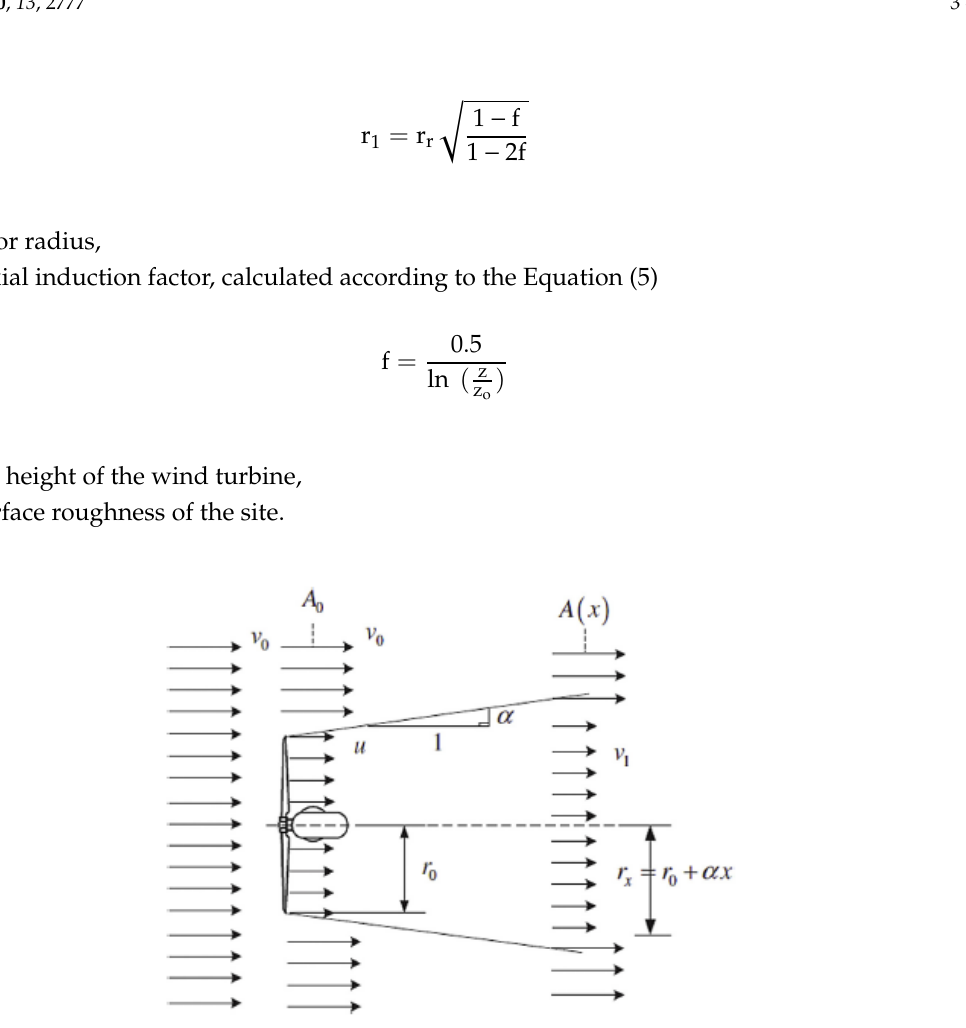
Figure 1. Schematic of the wind decrease downstream the wind turbine.